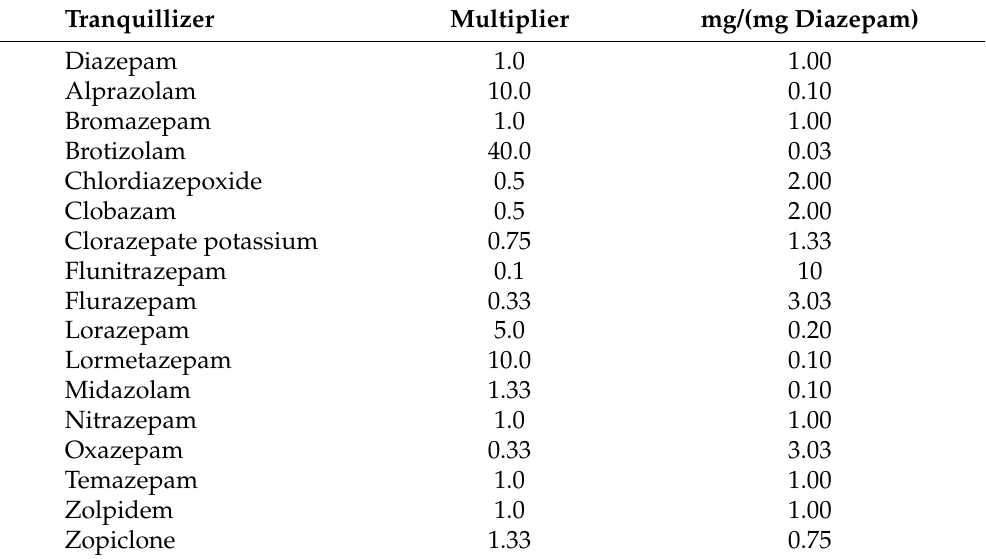
Table 2. List of tranquillizers considered in this study, along with the multipliers used for scaling the doses of those tranquillizers to a diazepam-equivalent dose. The last column is the inverse of the centre